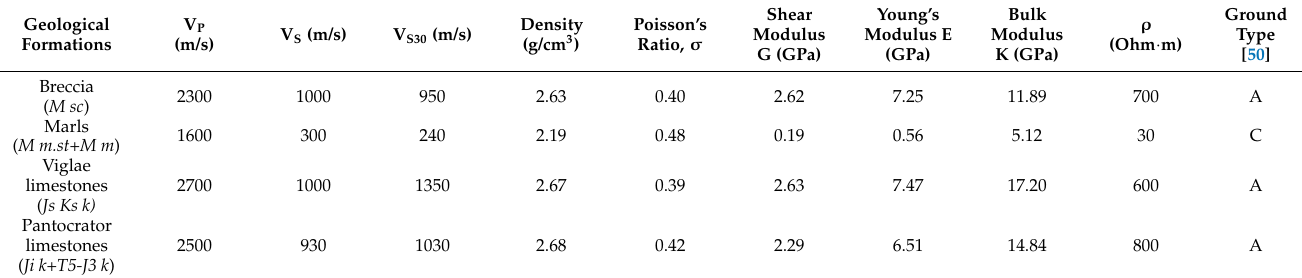
Table 4. Seismic velocities and the corresponding elastic moduli and ground types (based on [50]) of the geological formations of Corfu and Lefkada